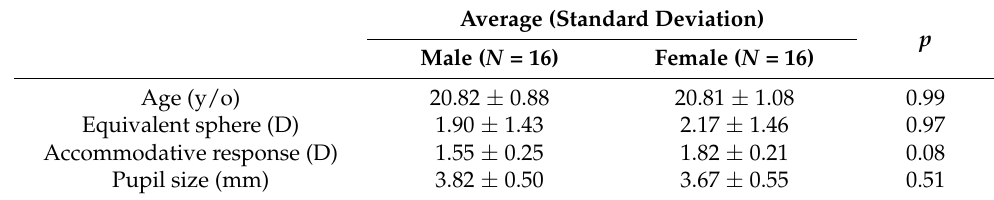
Table 1. The baseline of the